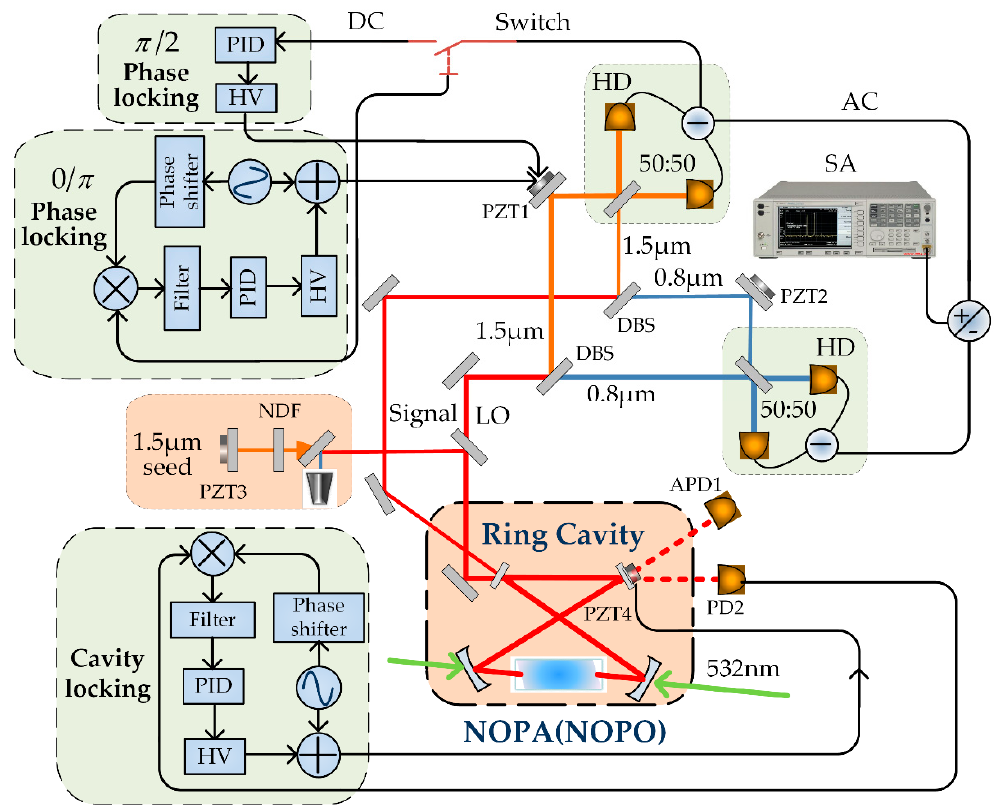
Figure 3. Schematic of the experimental setup. NOPO: nondegenerate optical parametric oscillator; NOPA: nondegenerate optical parametric amplifier; PZT: piezoelectric transducers; PD: photodetectors; APD: avalanche photodetector; HD: balanced homodyne detector, NDF: neutral density filter; LO: local oscillator; DBS: dichroic beam splitter; PID: proportional-integral-derivative controller; HV: high voltage amplifier; SA: spectrum analyzer. Black lines denote the electrical channels for measurement and control. Green line, orange lines, and blue lines represent the pump laser, 1.5 µ m, and 0.8 µ m optical fields, respectively.